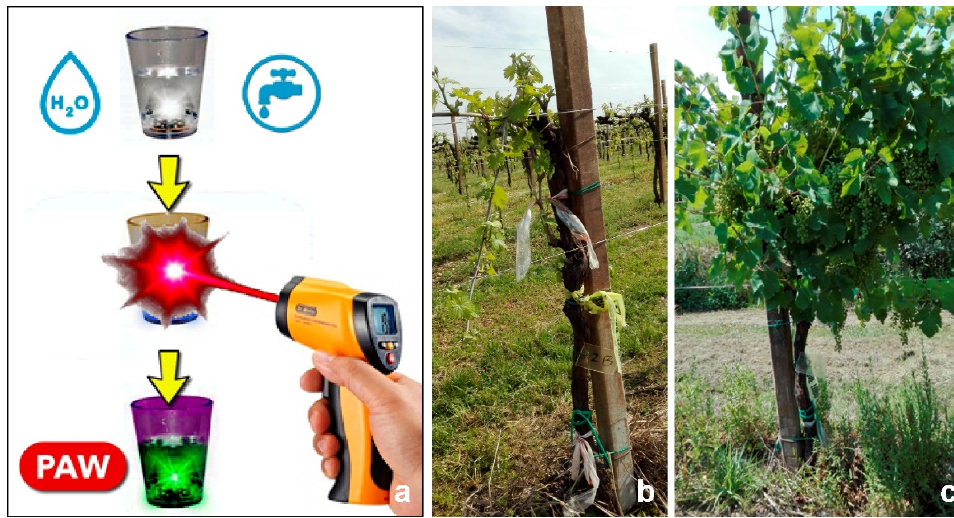
Figure 4. ( a ) scheme to produce PAW; ( b ) grapevine plant before and ( c ) after the PAW appli- cation for a period of three years.